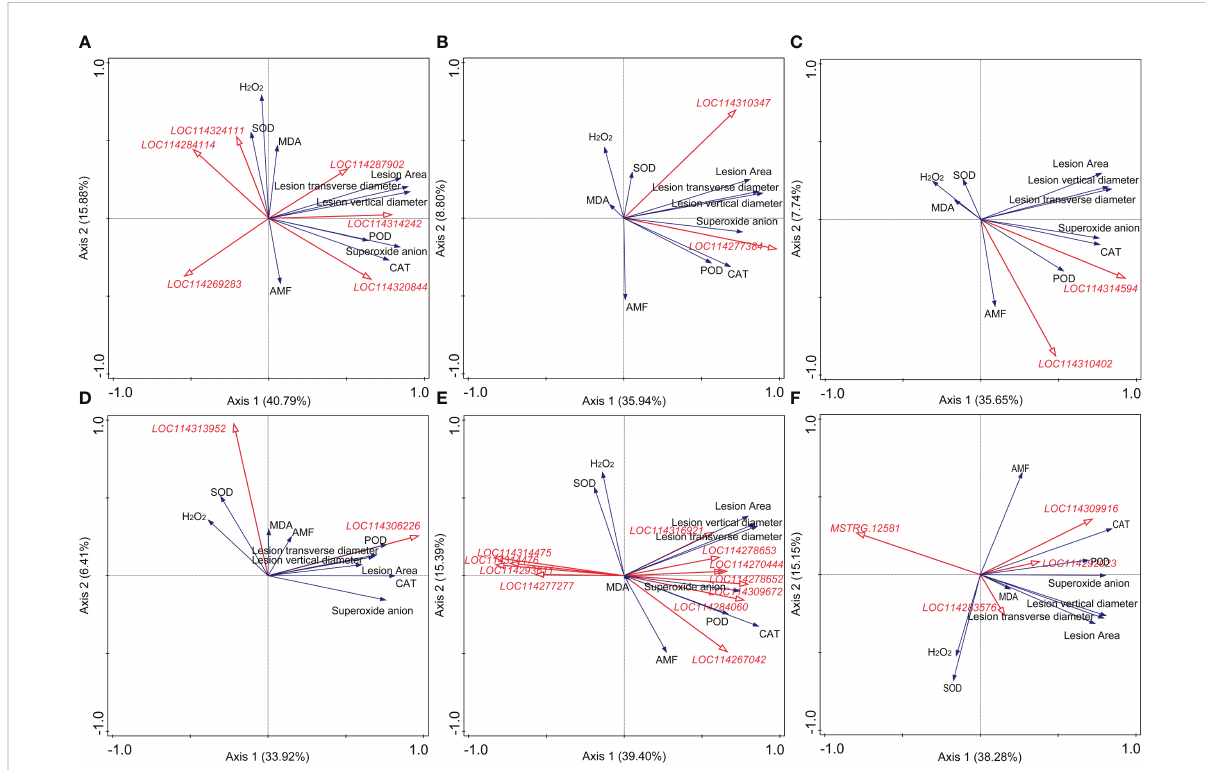
FIGURE 4 Redundancy analysis (RDA) indicating the correlations between key differentially expressed genes (DEGs) related to different categories and main physiological indexes. (A) DEGs related to auxin. (B) DEGs related to ethylene. (C) DEGs related to abscisic acid. (D) DEGs related to pathogenesis- related (PR) proteins. (E) DEGs related to the antioxidant system. (F) DEGs related to the fl avonoid metabolism. AMF: arbuscular mycorrhizal fungus; H2O2: hydrogen peroxide; MDA: malondialdehyde; CAT: catalase; SOD: superoxide dismutase; POD: peroxidase. Blue and red arrows indicated various physiological indexes and key DEGs induced by arbuscular mycorrhizal fungus inoculation and Colletotrichum camelliae infection, respectively. The annotation of DEGs in Figure 5, fi lled with yellow, was listed in Supplementary Material 3. Physiological